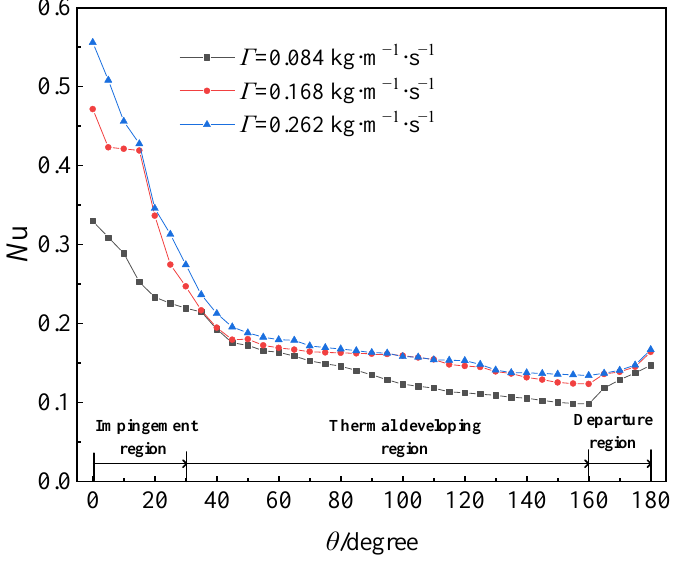
Figure 6. Local Nusselt number around tube under various spraying densities.